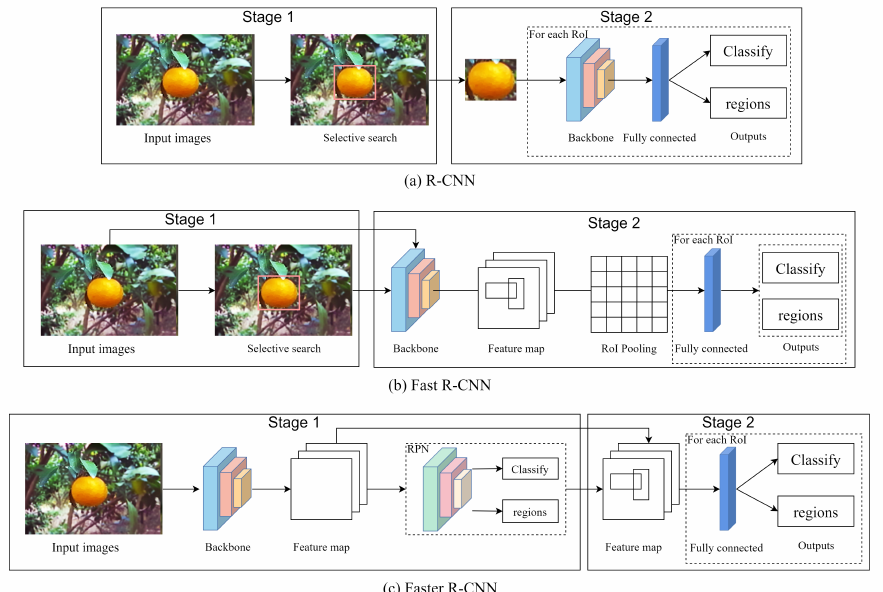
Figure 5. Classification-based two-stage target detection algorithms.